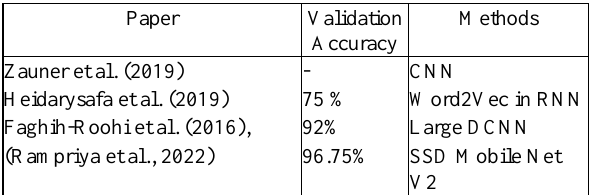
Table 1. Related work carried out of using DNN in